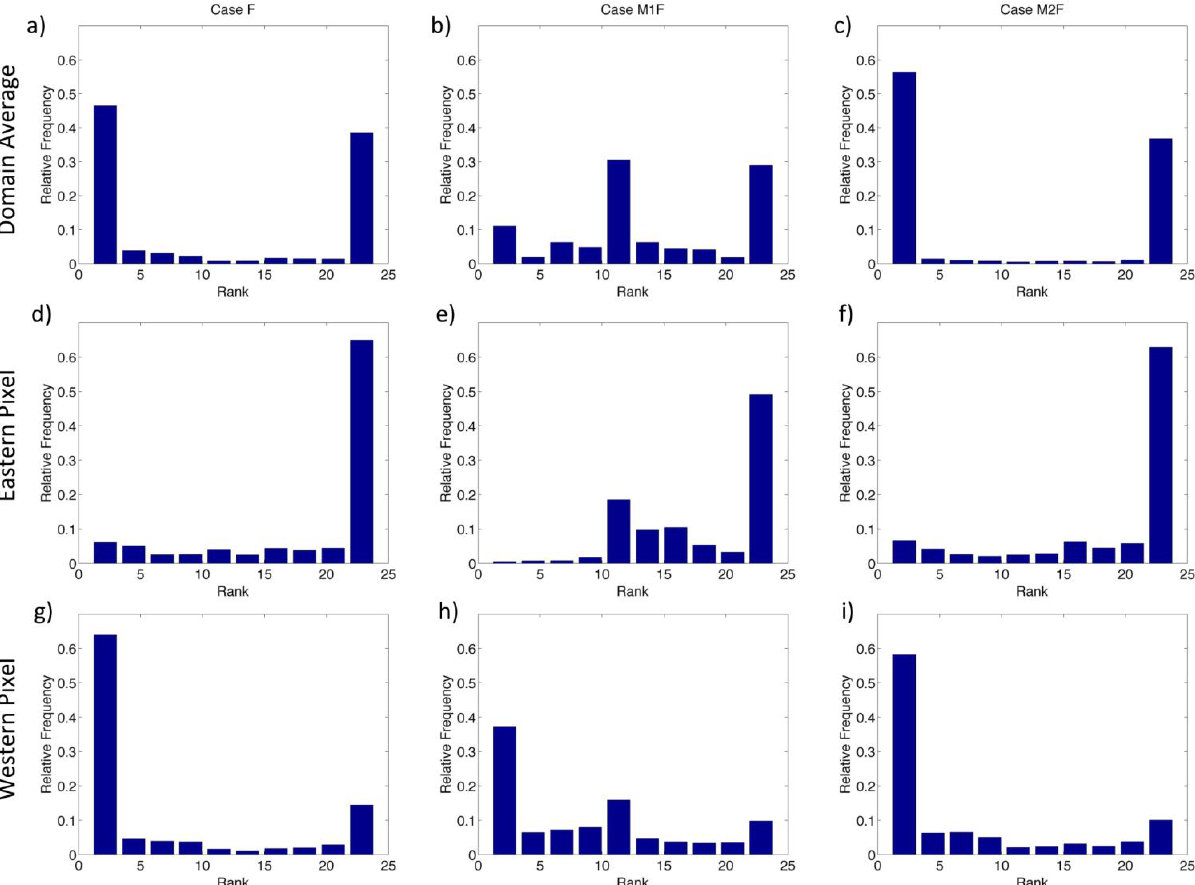
Figure 11 Rank histograms for cases F (a, d, g), M1F (b, e, h) and M2F (c, f, i) at the domain average scale (a, b, c), at the grid cell 833 Fig. 11. Rank histograms for cases F (a, d, g) , M1F (b, e, h) and M2F (c, f, i) at the domain average scale (a, b, c) , at the grid cell shown in Fig. 5, located in the eastern region of the study area (d, e, f) , and at the grid cell shown in Fig. 6, located in the western region of the study area (g, h, i)